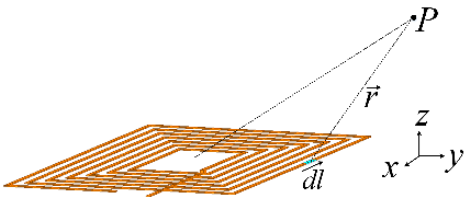
Figure 3. H-field calculation diagram.